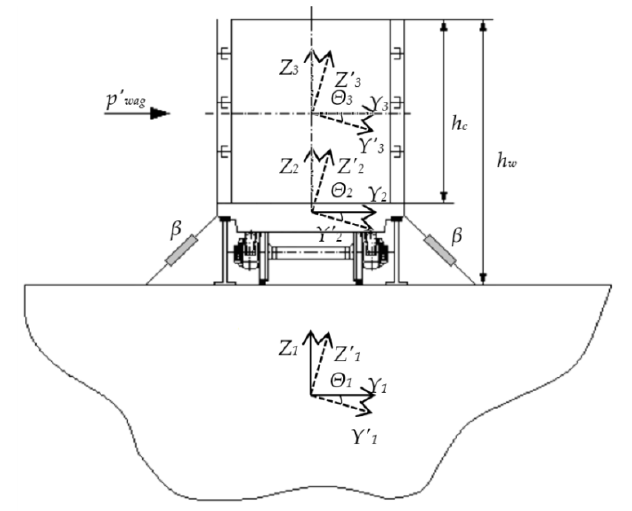
Figure 3. Diagram of a flat wagon with a container.